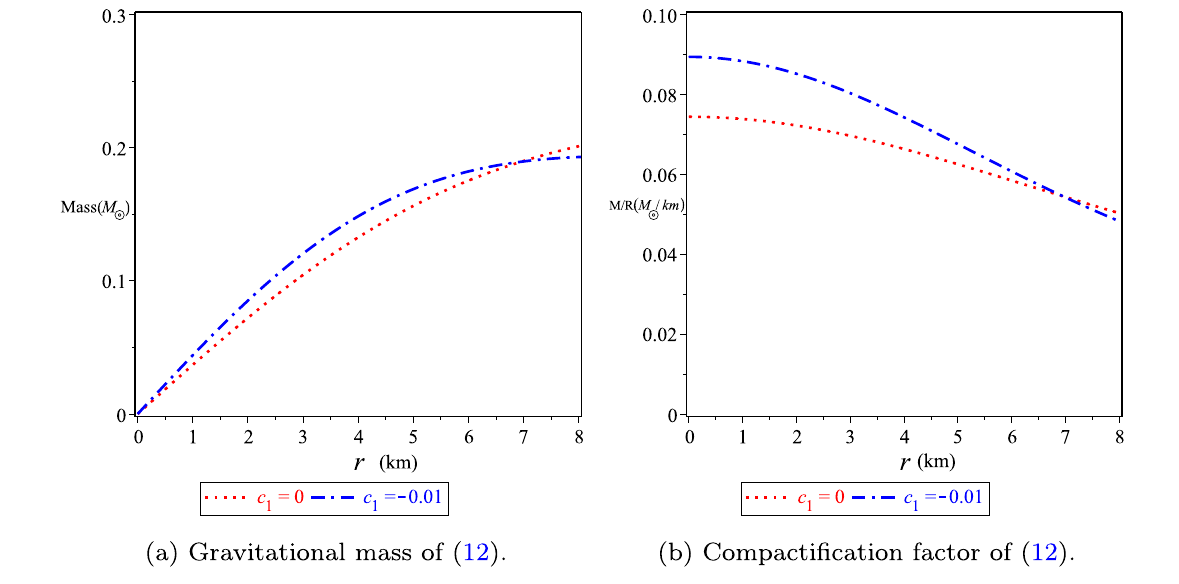
Fig. 9 Gravitational mass and compactification factor of solution